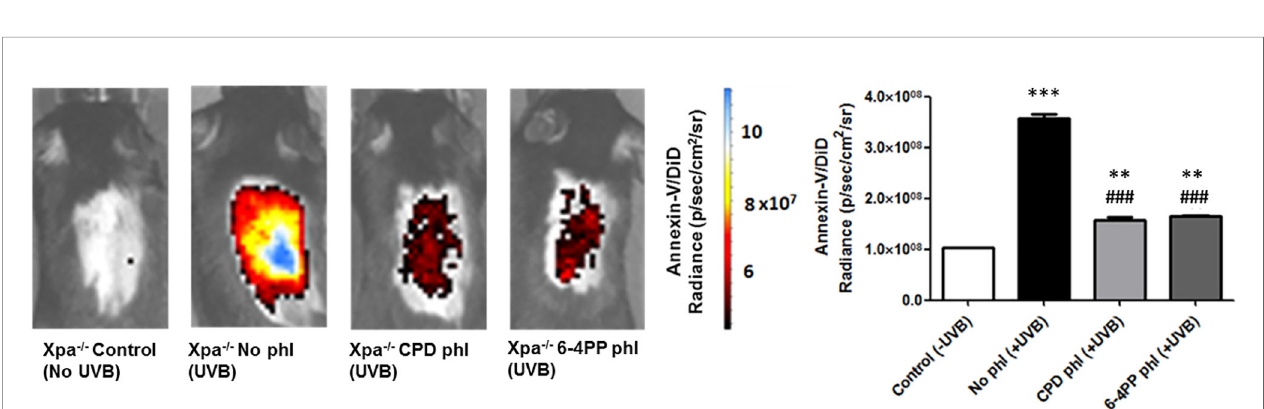
FIGURE 2 | In vivo effect of keratinocyte-speci fi c photorepair of CPDs and 6-4PPs on UVB-induced apoptosis in Xpa-/- mice. Apoptosis was analyzed by in vivo imaging using Annexin-V/DiD fl uorophore containing nanoparticles, 48 h after UVB (200 J/m2) irradiation. Radiance of DiD containing nanoparticles were quanti fi ed in the central region of Xpa-/- mice exposed dorsal skin using Living Image 4.0 software, n = 3. Asterisks (*) indicate a statistically signi fi cant difference between the designated group and the negative, Xpa-/- non-irradiated, controls, while the pound signs (#) indicate a signi fi cant difference between the designated group and the positive control group, Xpa-/- mice with no photolyase UVB-irradiated. “ * ” or “ # ” : p<0.05, “ ** ” or “ ## ” : p<0.01, and “ *** ” or “ ### ” :